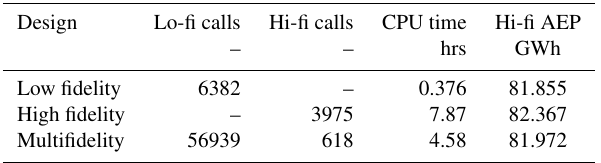
Table 6. Optimization results for the wind power plant layout AEP maximization